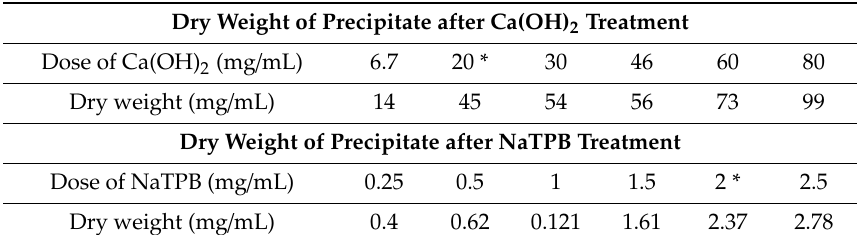
Table 2. Dry weight of precipitate after Ca(OH) 2 and NaTPB treatment.